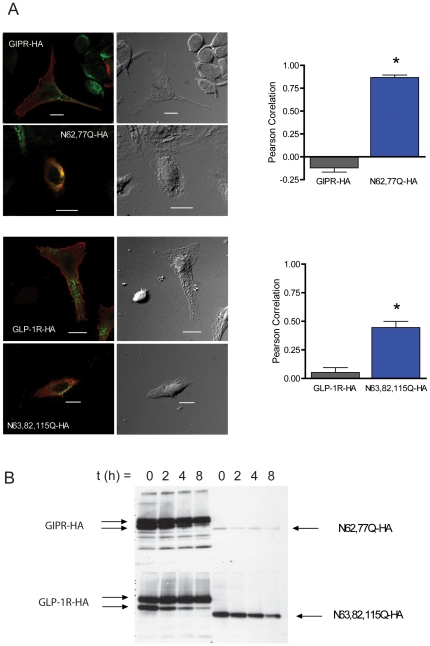
N-glycosylation-deficient incretin receptors are retained in the endoplasmic reticulum and degraded to a greater extent than wild type.(A) Co-localization of both wild type and N-glycosylation-deficient receptors with calnexin shown in photographs (left); the correlation of their intensities is shown in the bar graphs (right). (B) Western blots showing wild type and N-glycosylation-deficient incretin receptors at indicated time points following cycloheximide administration to CHO cells expressing each receptor.